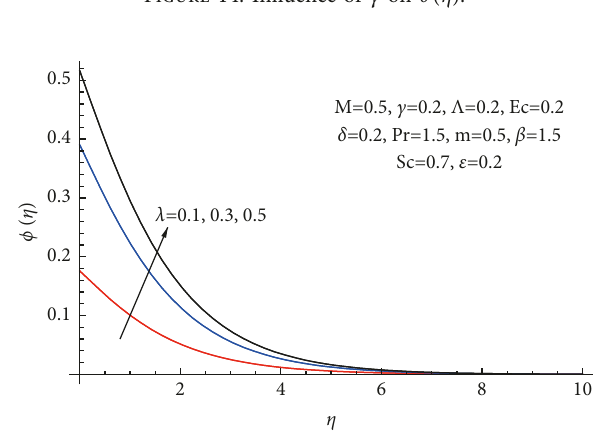
Figure 12: Influence of Ec on θ ( η ) .